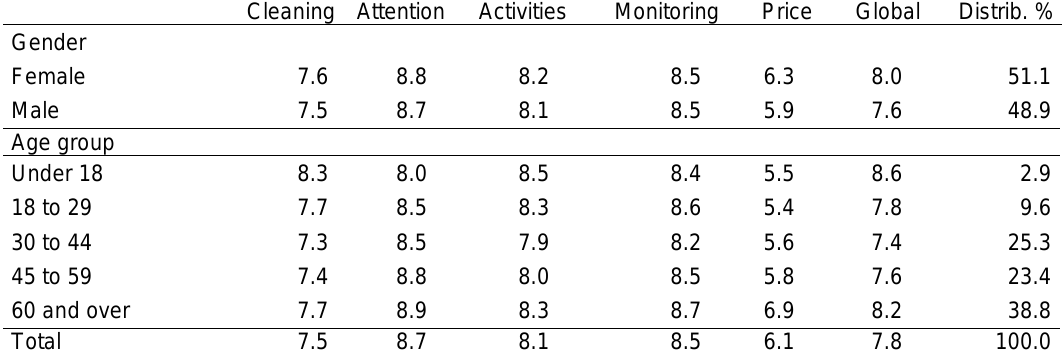
Table 17. Assessment of sports facilities by gender and age group (2017). Centre sports facility. Cleaning Attention Activities Monitoring Price Global Distrib.